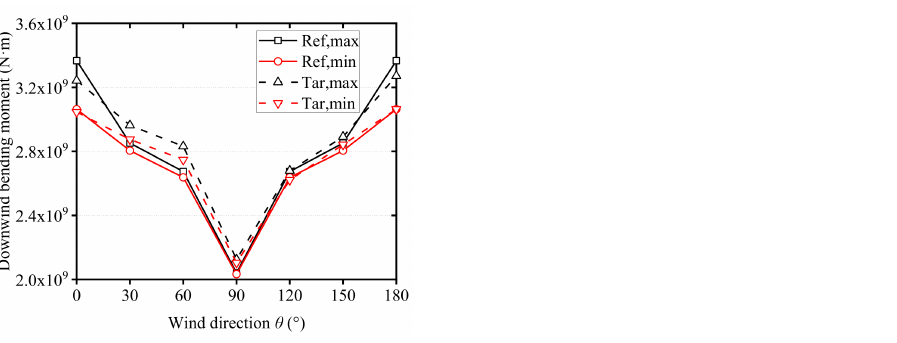
Figure 12. Downwind moments of the target and reference models for different wind directions.